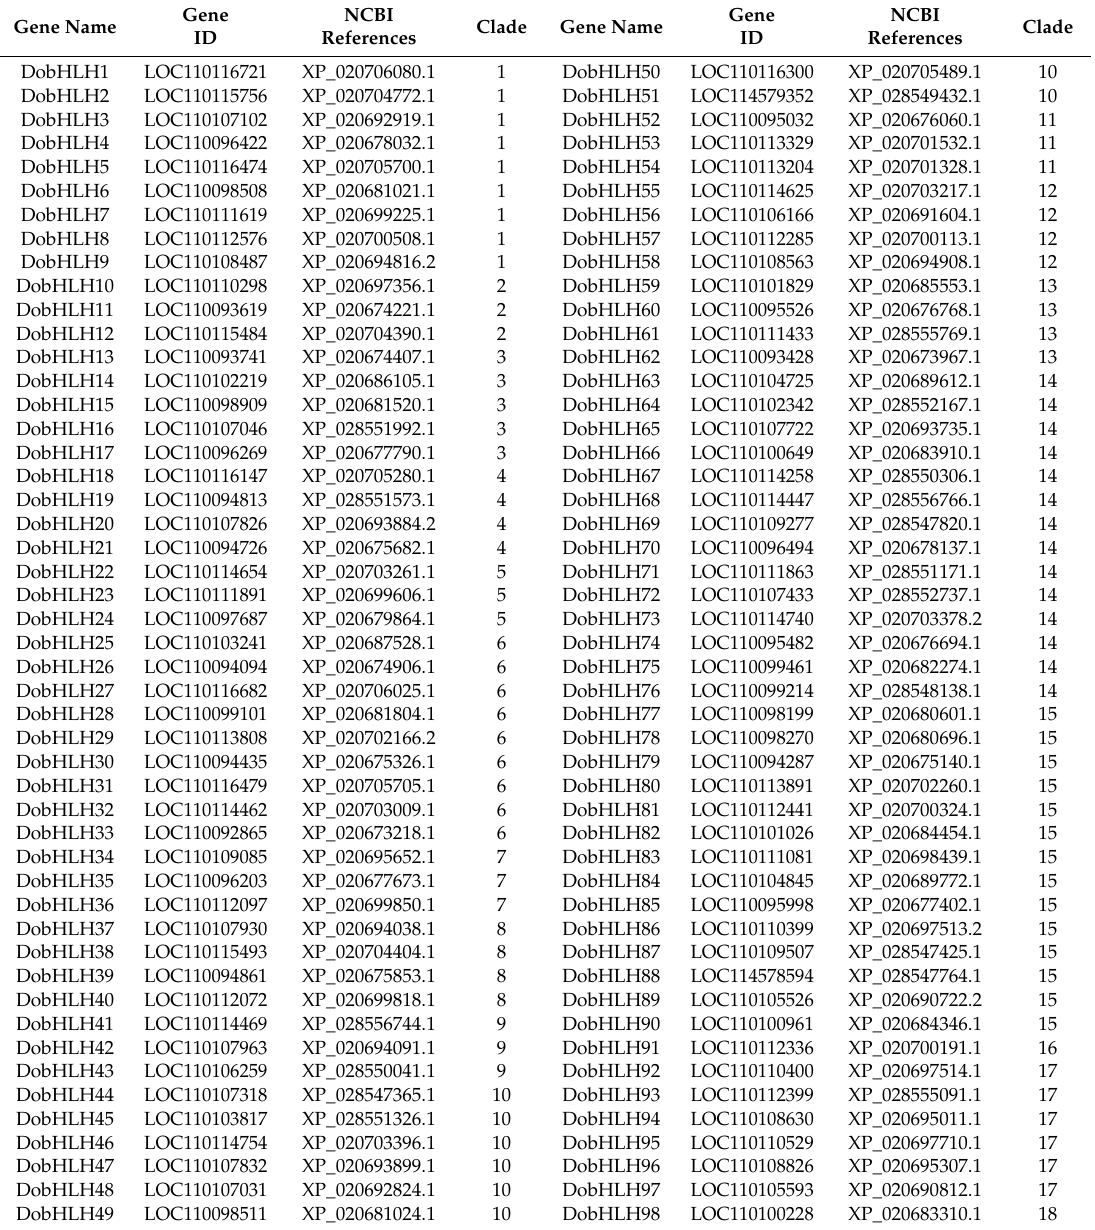
Table 1. The list of 98 DobHLH genes in D. o ffi